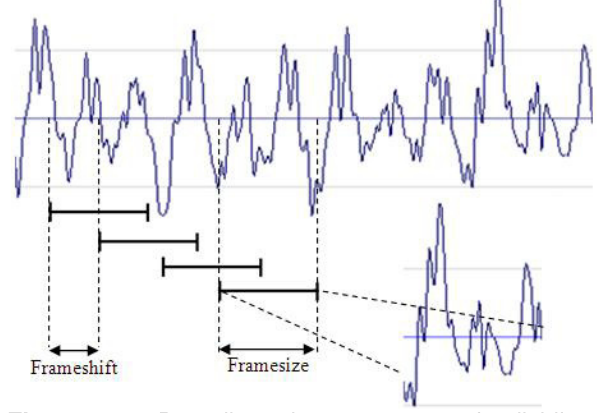
Figure 5. Describe the process of dividing the discrete